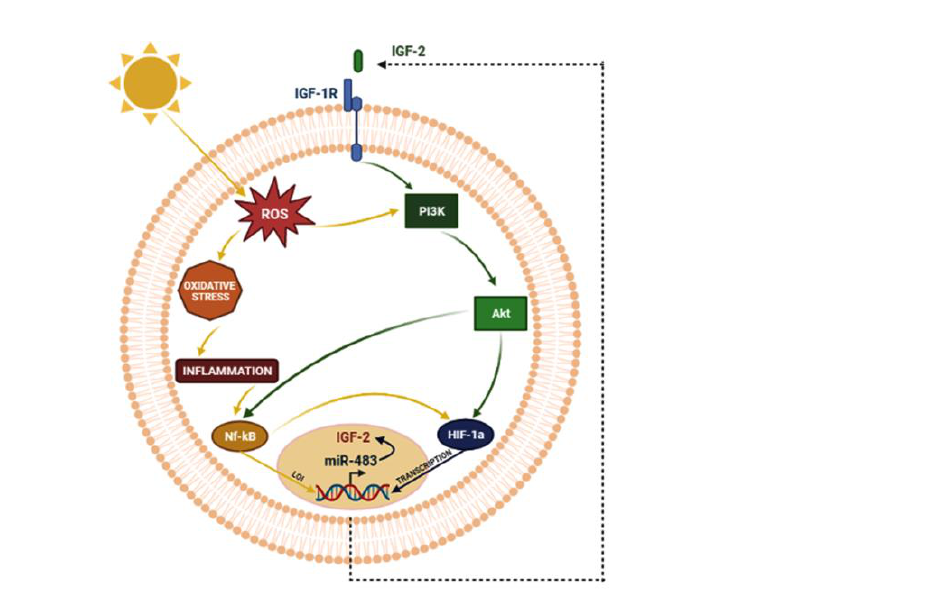
Figure 6. Possible crosstalk between UV-induced oxidative stress and hypoxia in pterygium (BioRen-